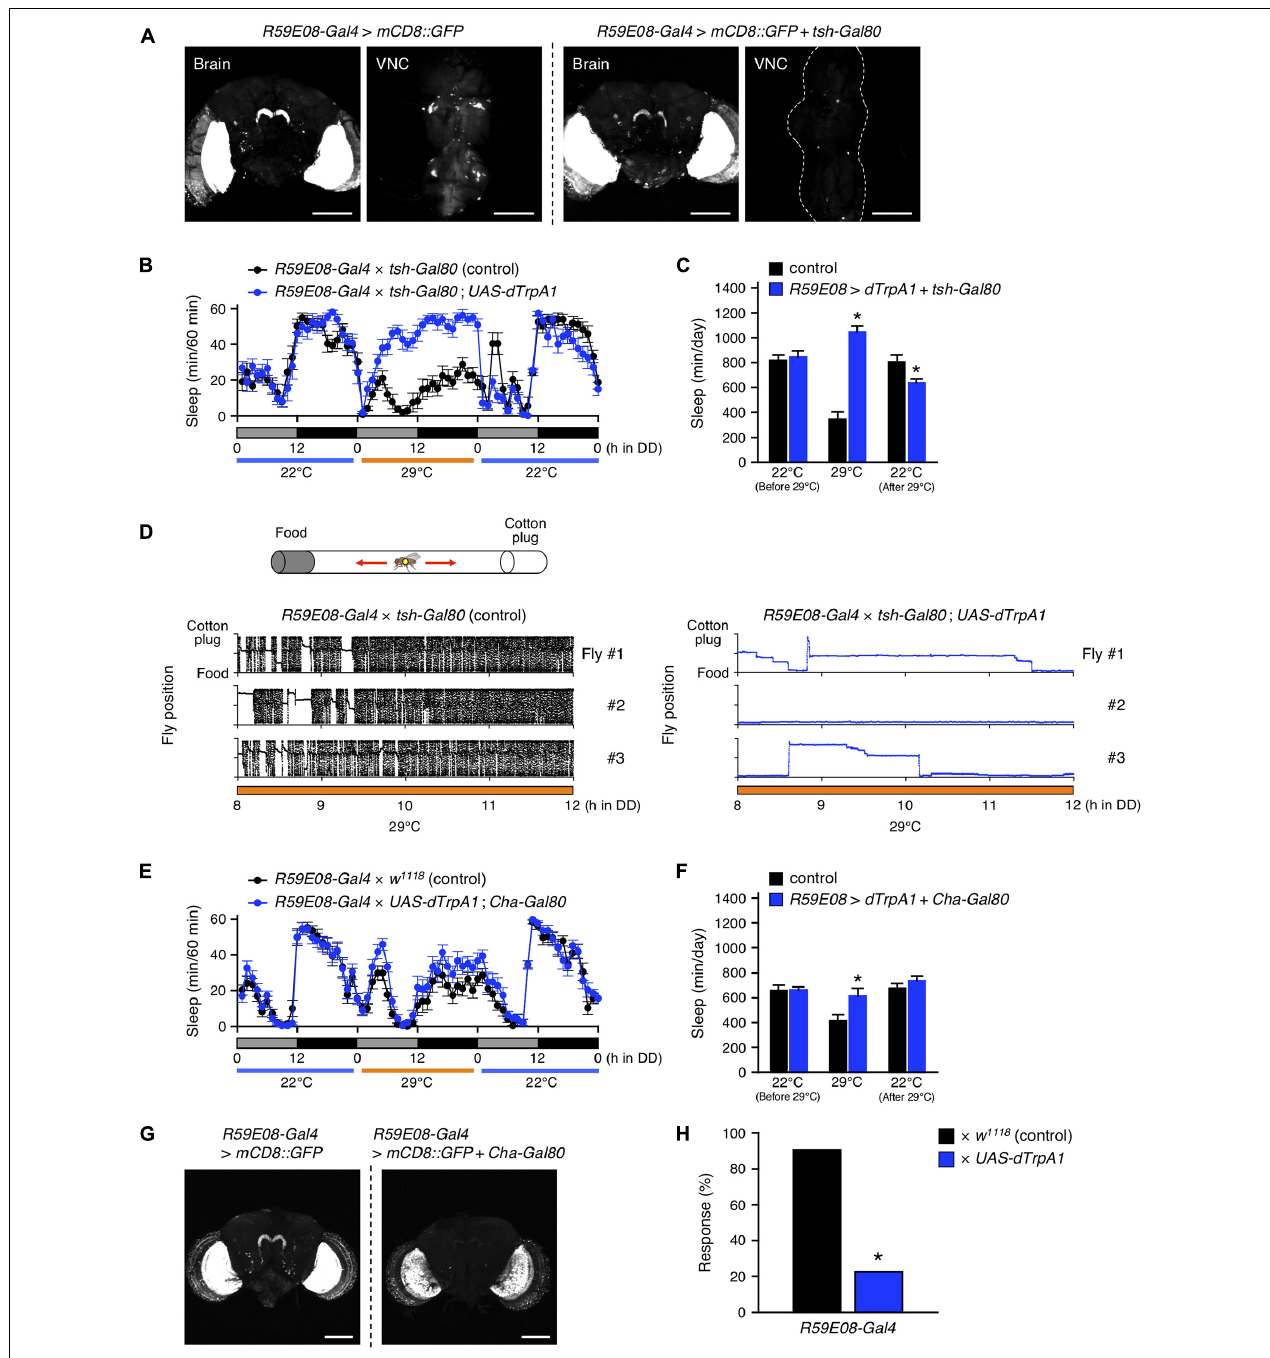
FIGURE 3 | R59E08-Gal4 -expressing PB interneurons promote sleep. (A) Maximum-intensity projection of the confocal brain or ventral nerve cord (VNC) images of flies expressing UAS-mCD8::GFP under the control of R59E08-Gal4 (left two panels) or R59E08-Gal4 with tsh-Gal80 (right two panels). Transgene tsh - Gal80 efficiently suppressed R59E08-Gal4 driven GFP expression in the VNC, while did not in the brains. Scale bars indicate 100 µ m. (B,C) Sleep profiles in 60-min intervals (B) or total daily sleep (C) for control flies ( R59E08-Gal4 × tsh-Gal80 , black circles or bars, n = 12) or flies expressing dTrpA1 in R59E08-Gal4 brain neurons ( R59E08-Gal4 × tsh-Gal80 ; UAS-dTrpA1 , blue circles or bars, n = 11) in DD. The behavior was monitored as described in Figure 2 . Data are presented as mean ± SEM. * p < 0.05 vs. control; two-way repeated measures ANOVA followed by simple main effect test. (D) Horizontal movements of three representative control flies ( R59E08-Gal4 × tsh-Gal80 , black circles) or flies expressing dTrpA1 in R59E08-Gal4 brain neurons ( R59E08-Gal4 × tsh-Gal80 ; UAS-dTrpA1 , blue circles) in a glass tube at 29 ◦ C during the late subjective day (CT 8 to CT 12). Positions of the cotton plug and the food were at the top and the bottom in each plot, respectively. The behavior of flies was recorded at 2 frames/sec using an infrared video camera in DD conditions. The fly position in a glass tube was calculated for